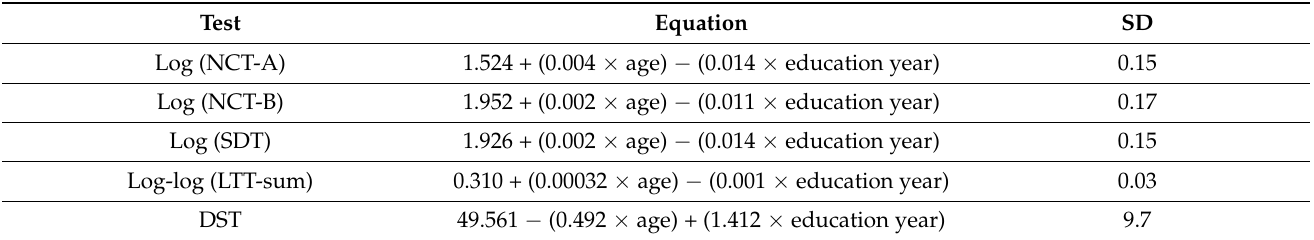
Table 3. Predictive equations of psychometric hepatic encephalopathy score of each sub-test. Test